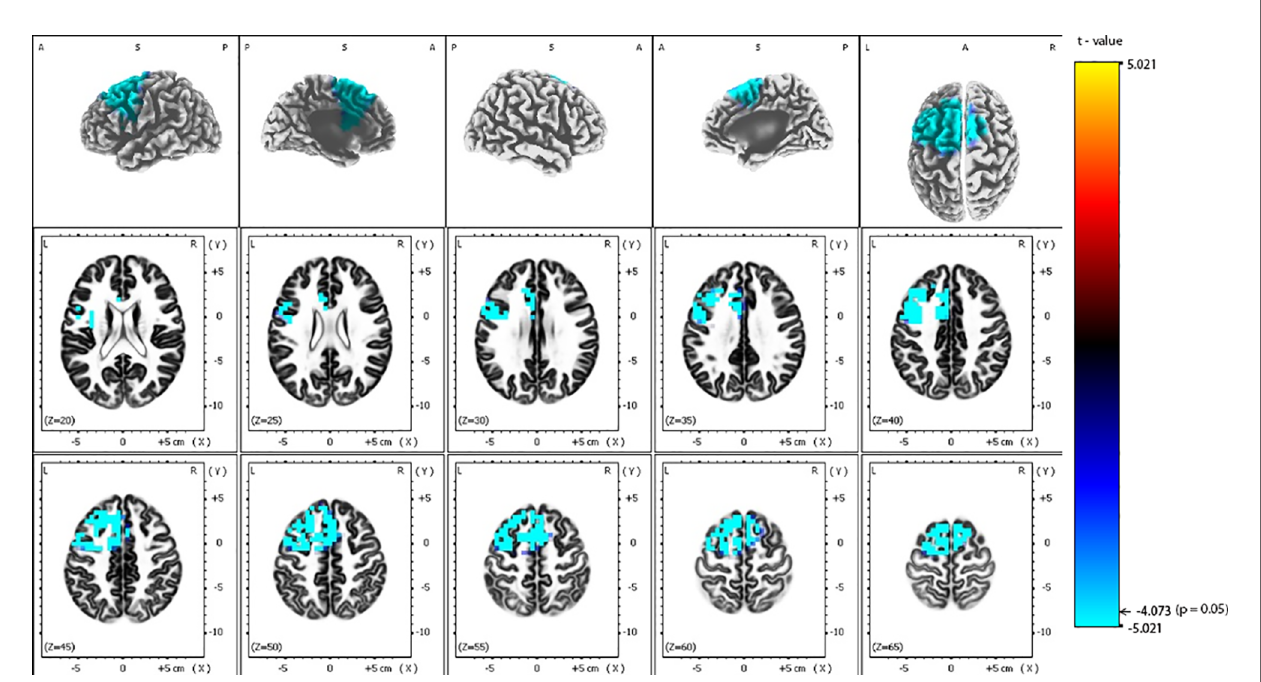
FIGURE 3 | Comparison of baseline exact low-resolution brain electromagnetic tomography (eLORETA) current density for beta-1 frequency band (12.5 – 18 Hz) between responders and non-responders to repetitive transcranial magnetic stimulation (rTMS) treatment. Surface-rendered (upper row) and axial sliced (middle and lower row) images depicting statistical nonparametric maps (SnPMs) are based on voxel-by-voxel independent t-tests of the eLORETA images based on the log- transformed power of the estimated electric current density. A signi fi cant decrease (p < 0.05) in the baseline beta-1 eLORETA current density for rTMS responders is shown mainly in the left frontal and limbic lobes, left insula and left anterior cingulate. Structural anatomy is shown in grayscale (A, anterior; P, posterior, S, superior; L, left, R, right); x, y, z = Talairach coordinates. The threshold value (t = -4.073) for statistical signi fi cance (corresponding to p=0.05) is reported at the color scale on the right side of the fi gure.